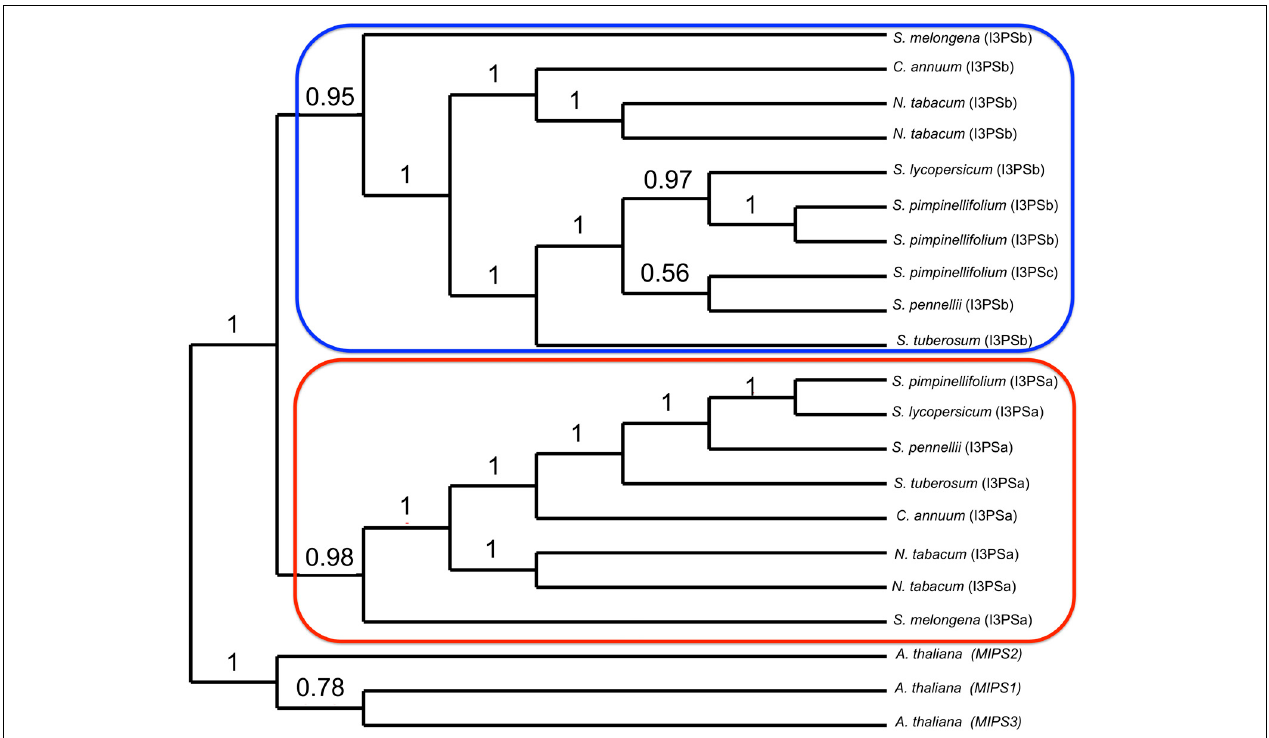
FIGURE 5 | Phylogenetic analysis of the inositol-3-phosphate synthase ( I3PS ) gene family in the Solanaceae family. Node values represent the percentage of 100 bootstrap replicates that support the topology. The I3PSa and I3PSb genes are encircled in red and blue, respectively. A. thaliana MIPS genes were used as